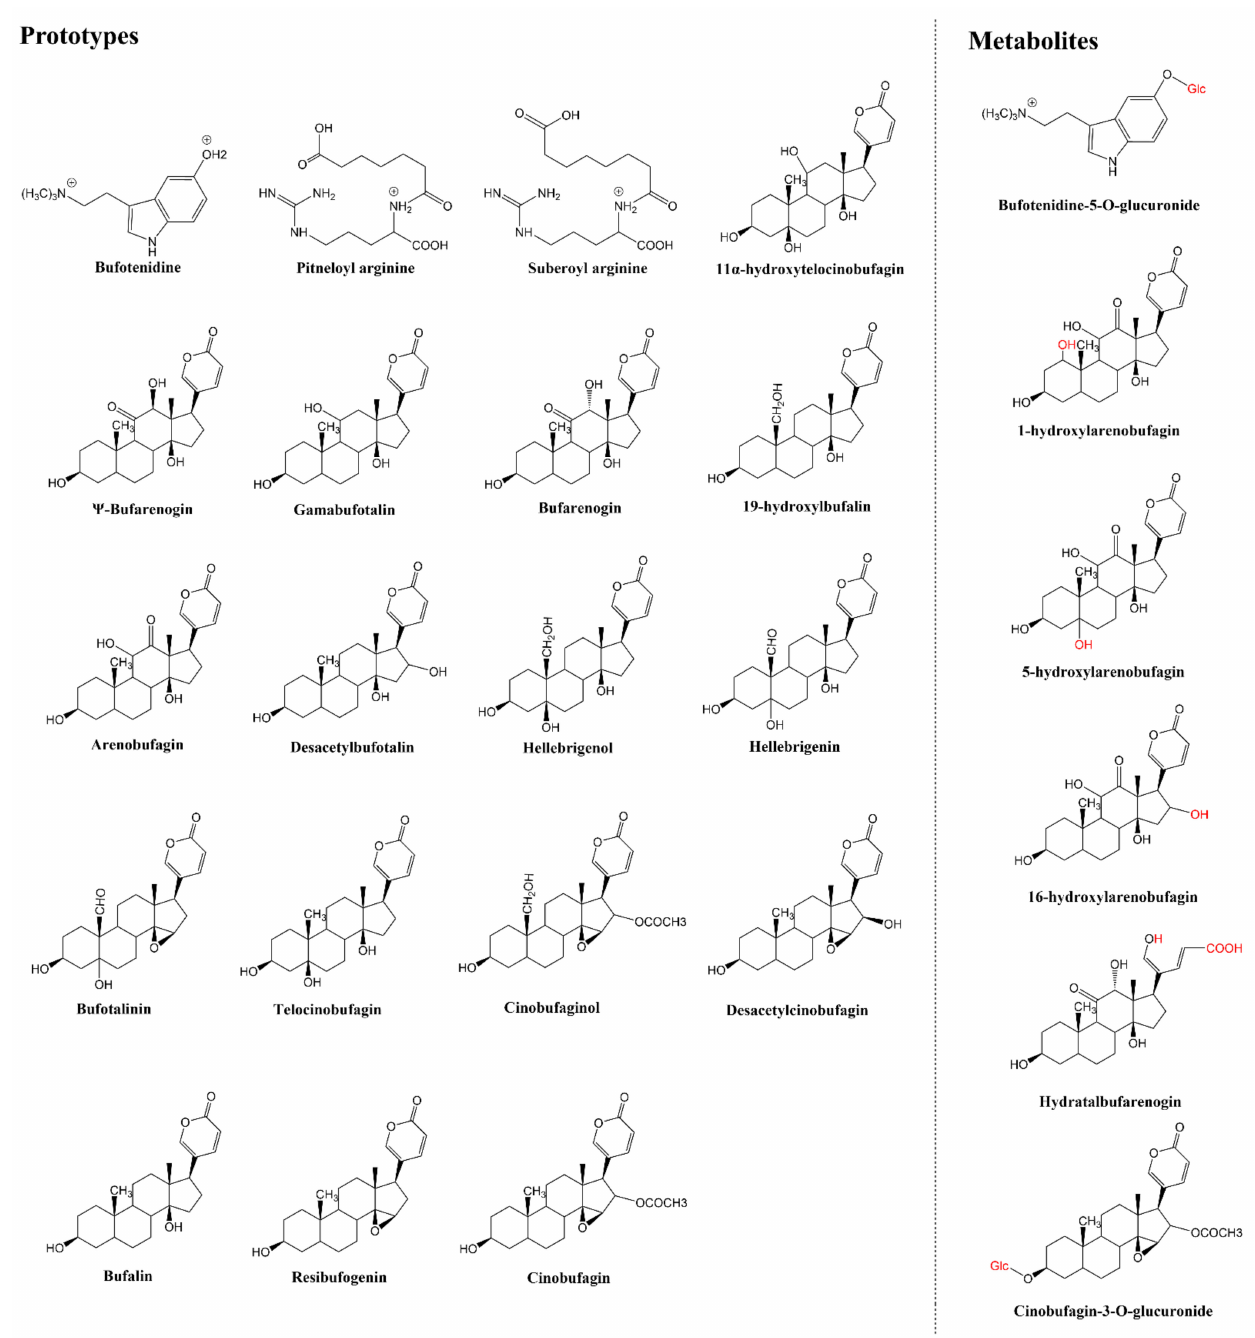
Figure 2. The detailed chemical structure of identified components of blood in rat